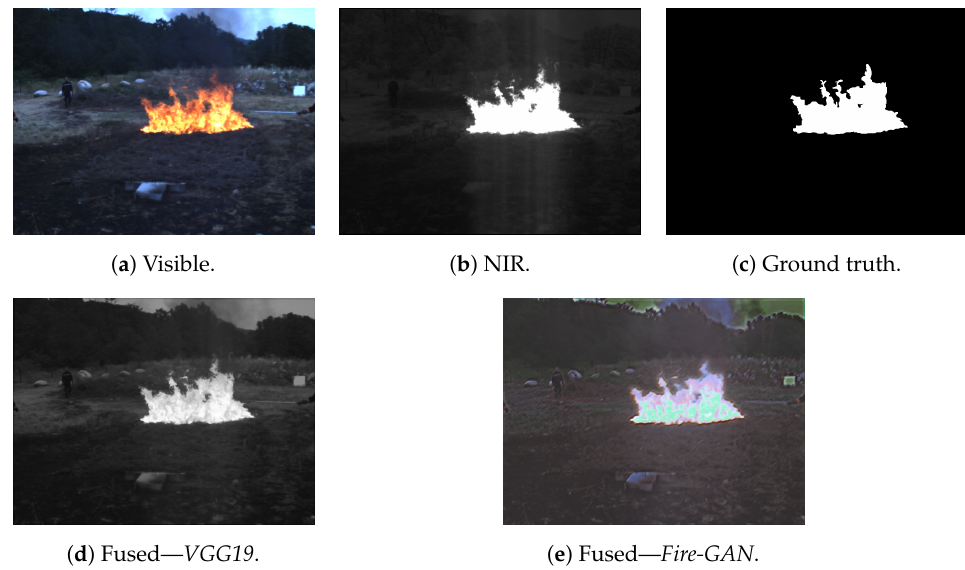
Figure 6. Sample visible, NIR, fused, and ground truth images employed in the present paper.